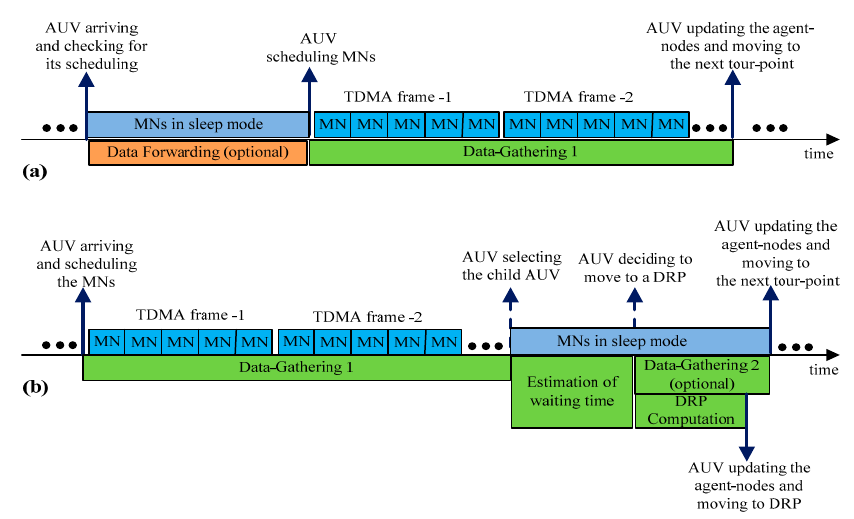
Figure 7. Events that may occur at a tour-point ( a ) AUV in mode-f ( b ) AUV in mode-r.